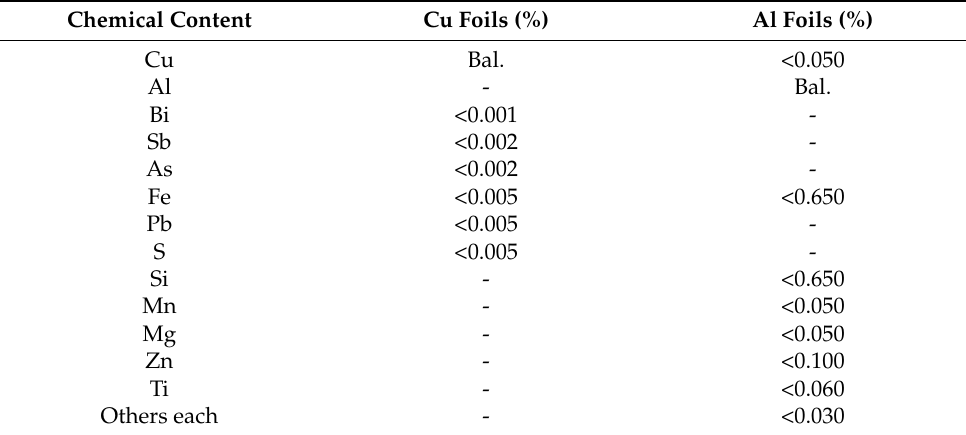
Table 4. Chemical composition of Cu and Al